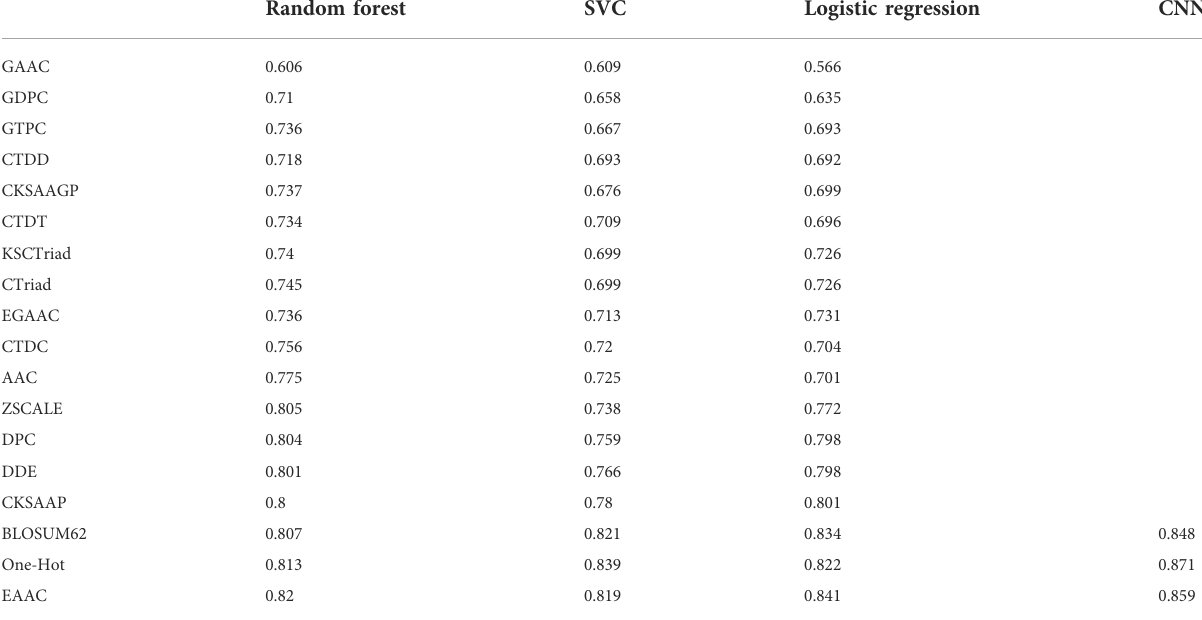
TABLE 2 Prediction performances of the models integrating different algorithms and various feature encoding approaches in ten-fold cross-